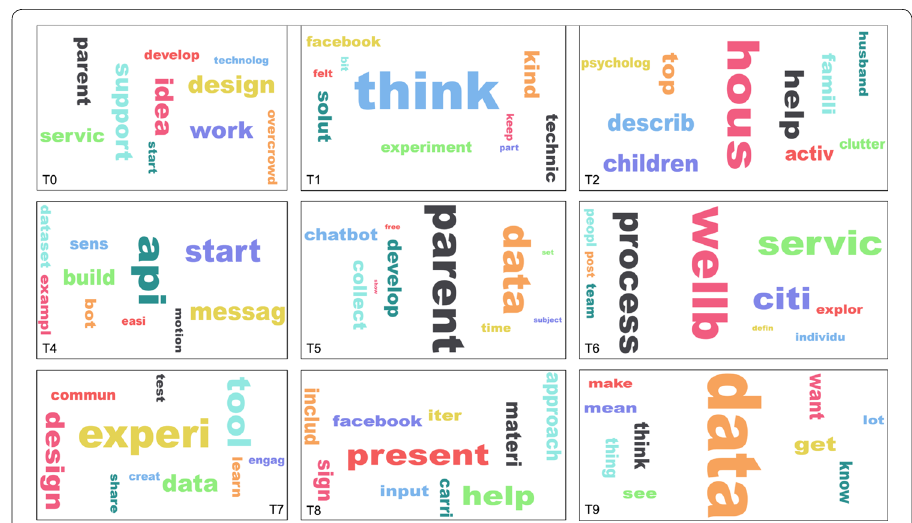
Fig. 3 Word clouds for Colour-in City’s LDA topics used for evaluation and interpretation